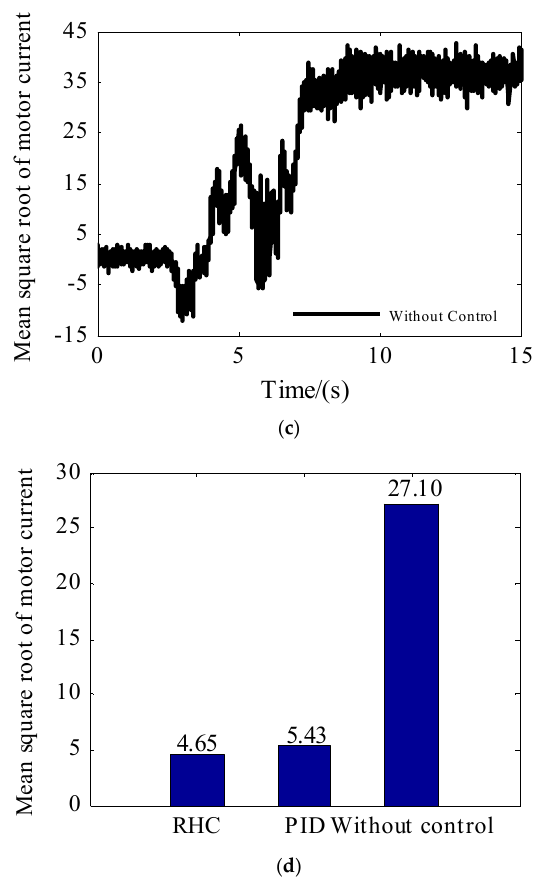
Figure 7. ( a ) Receding horizon-controlled current; ( b ) PID-controlled motor current; ( c ) Motor current without control; ( d ) Mean square root value of motor current.